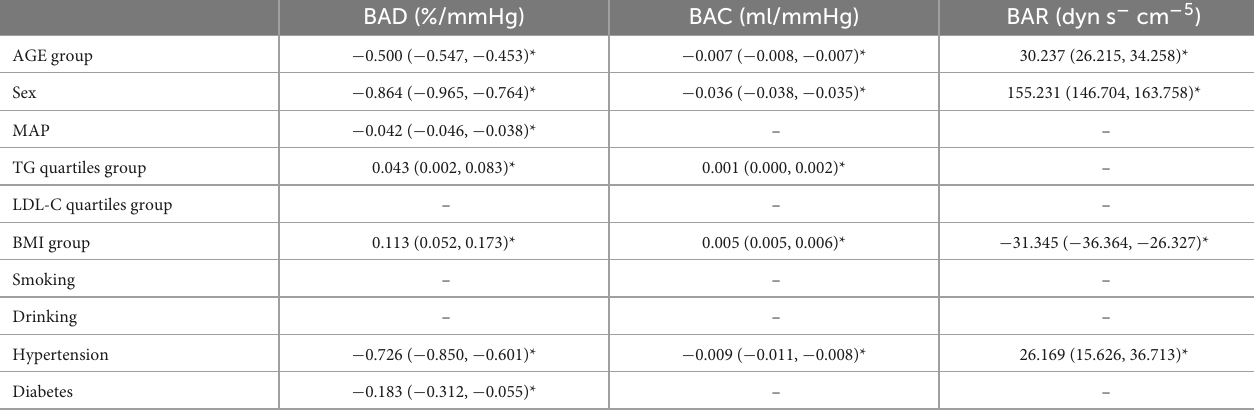
TABLE 4 Multivariate analysis of arterial elasticity